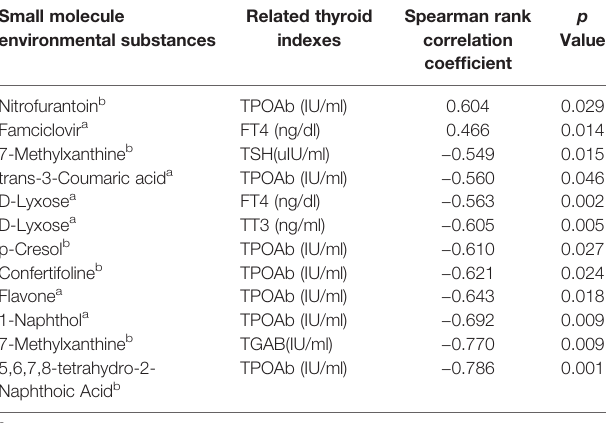
TABLE 5 | Correlation between environmental substances and thyroid indexes in GD group. Small molecule environmental substances